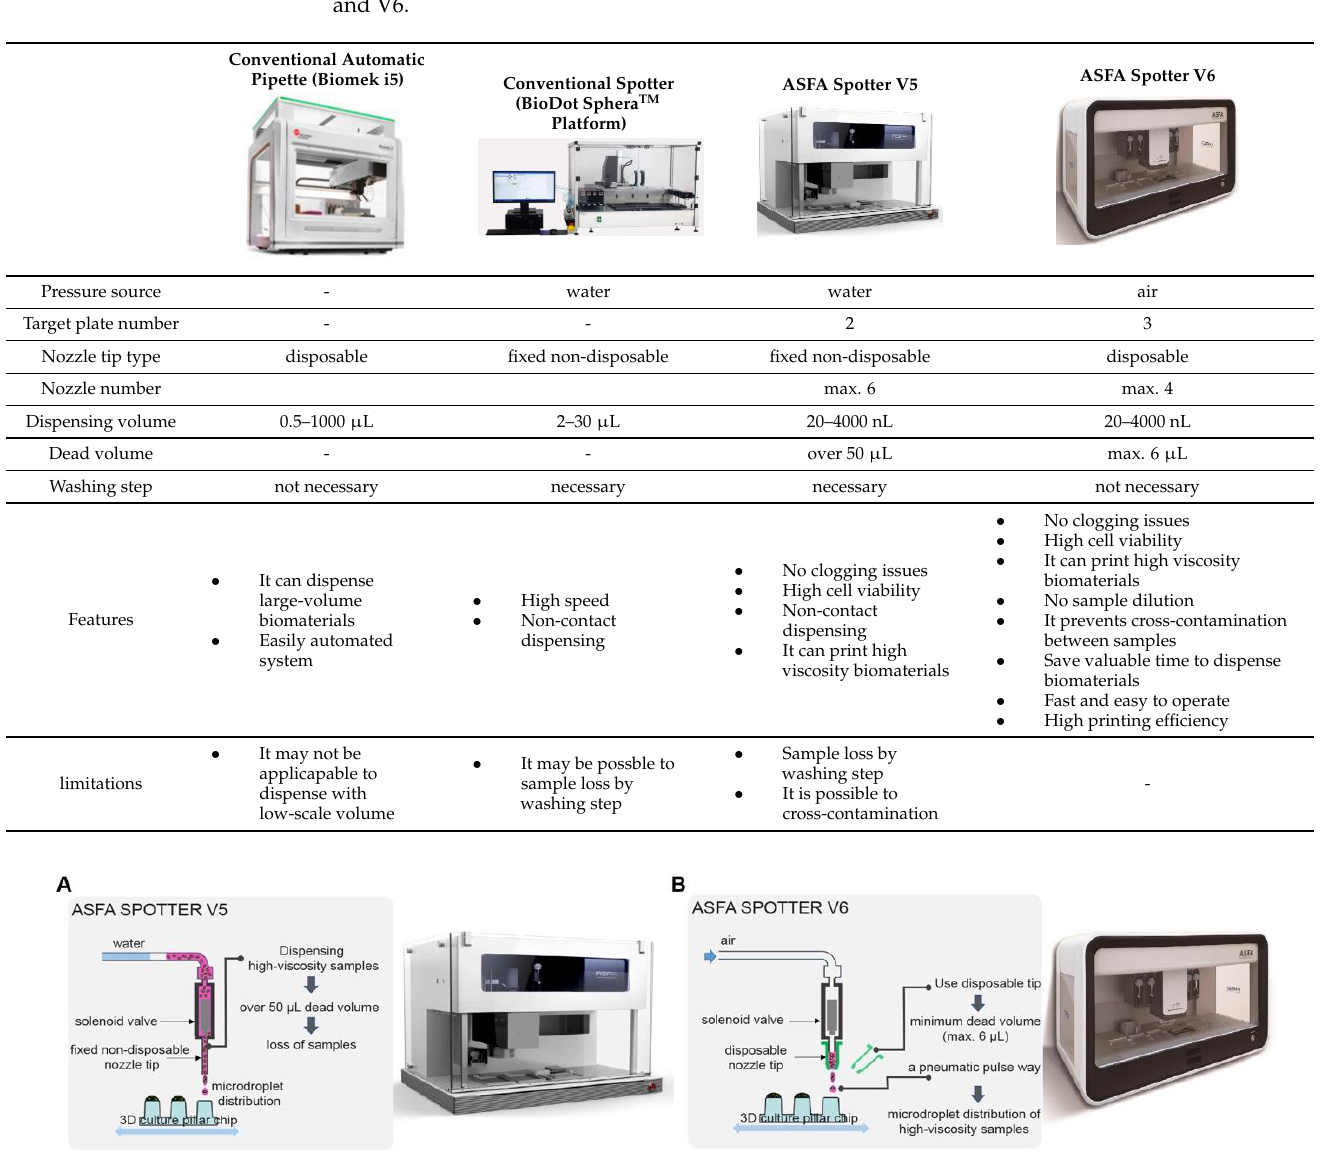
Figure 1. The scheme of ASFA Spotters. ( A ) ASFA Spotter V5. ( B ) ASFA Spotter V6.